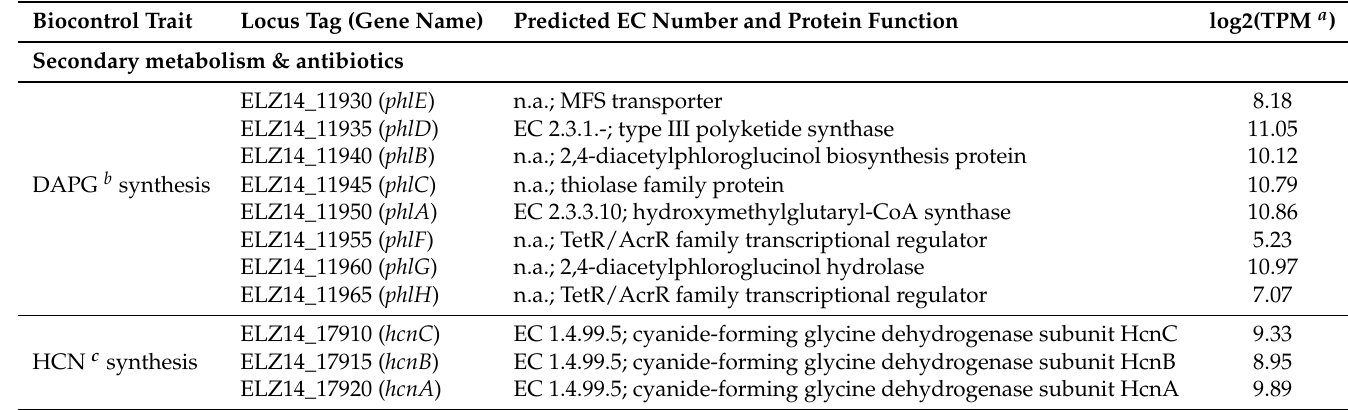
Table 5. Genetic biocontrol determinants of P. brassicacearum 3Re2-7—Secondary Metabolism and